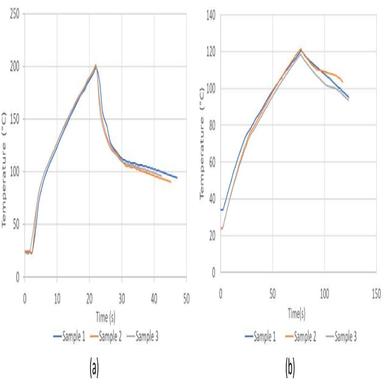
Temperature-time diagram (relative to exposure to the laser source), for (a) HDPE and (b) PET polymers.